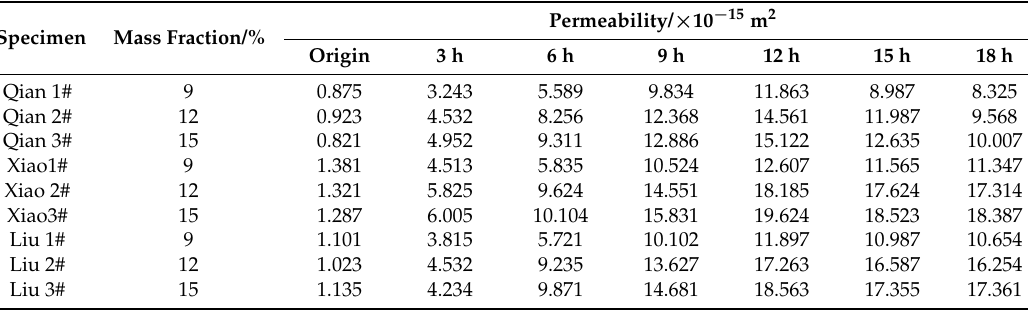
Table 3. Coal specimen permeability changes by